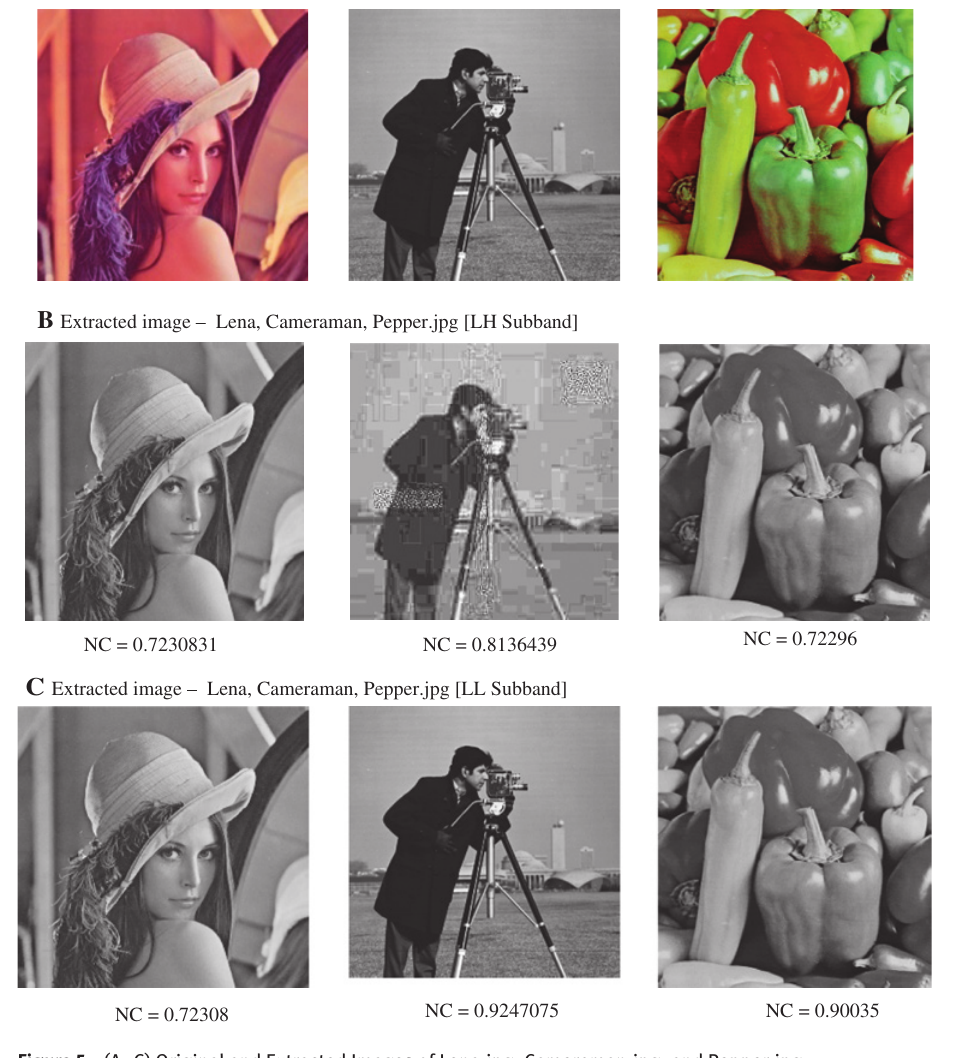
Figure 5: (A–C) Original and Extracted Images of Lena.jpg, Cameraman.jpg, and